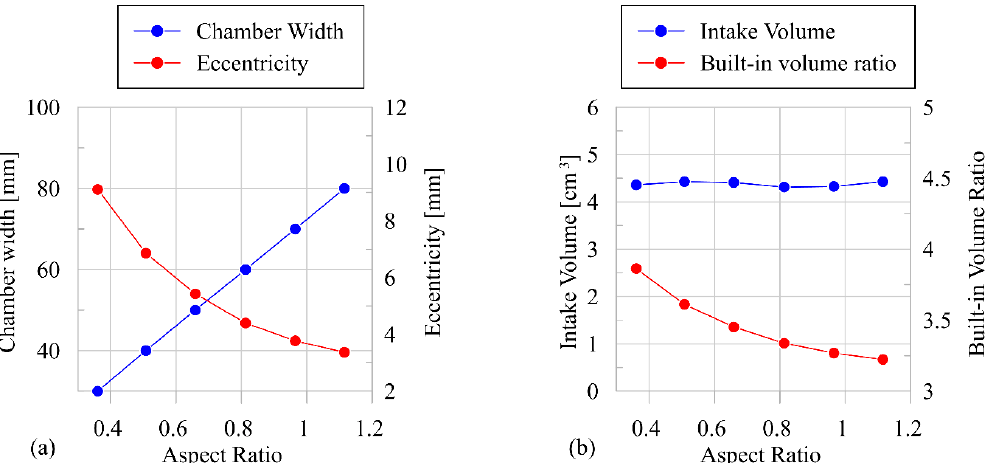
Figure 13. Results of the model-based design for revolution speed equal to 2000 RPM: ( a ) geometric configuration; ( b ) built-in volume ratio and intake volume.